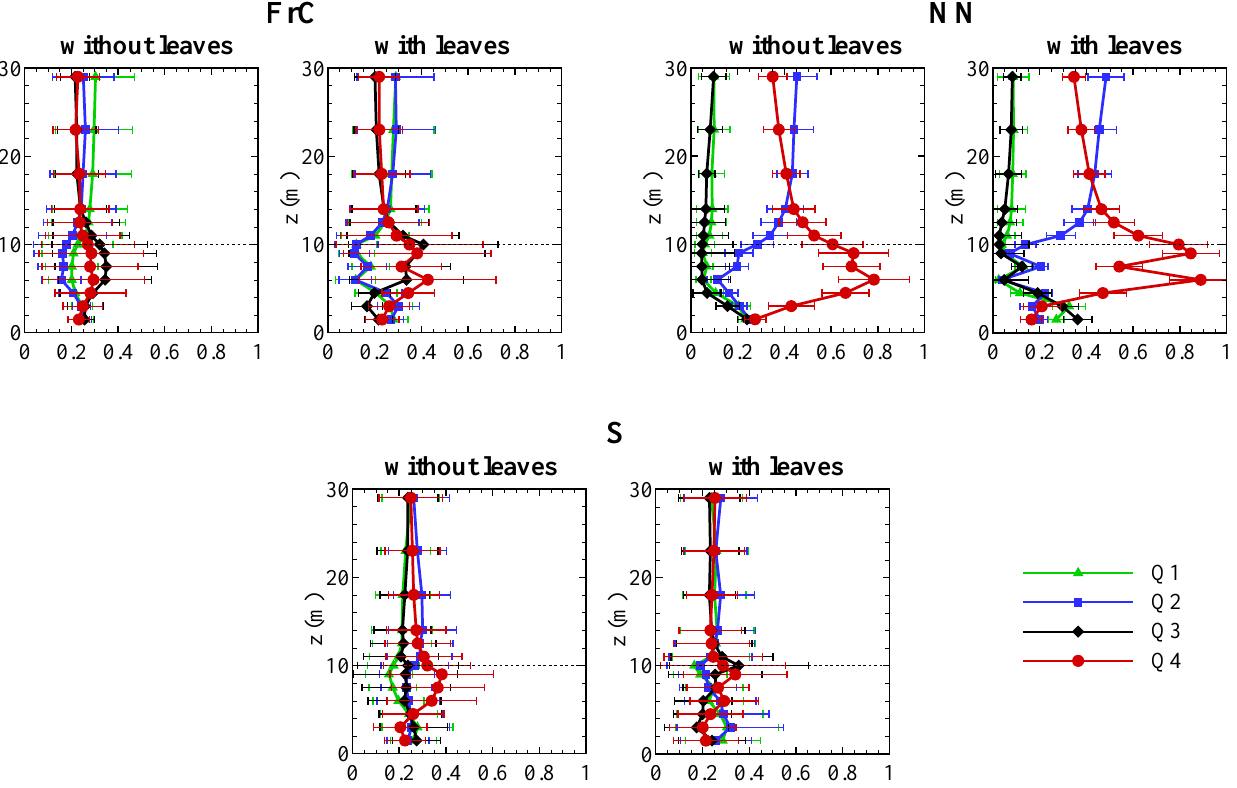
Fig. 1. Fraction of the momentum flux h u 0 w 0 i in each momentum quadrant as defined in Eq. (3) across the three main stability regimes (FrC, NN and S) and two seasonal periods. Quadrants are defined in Table 2. Error bars indicate the standard deviation of the fractions. The dashed line indicates the canopy